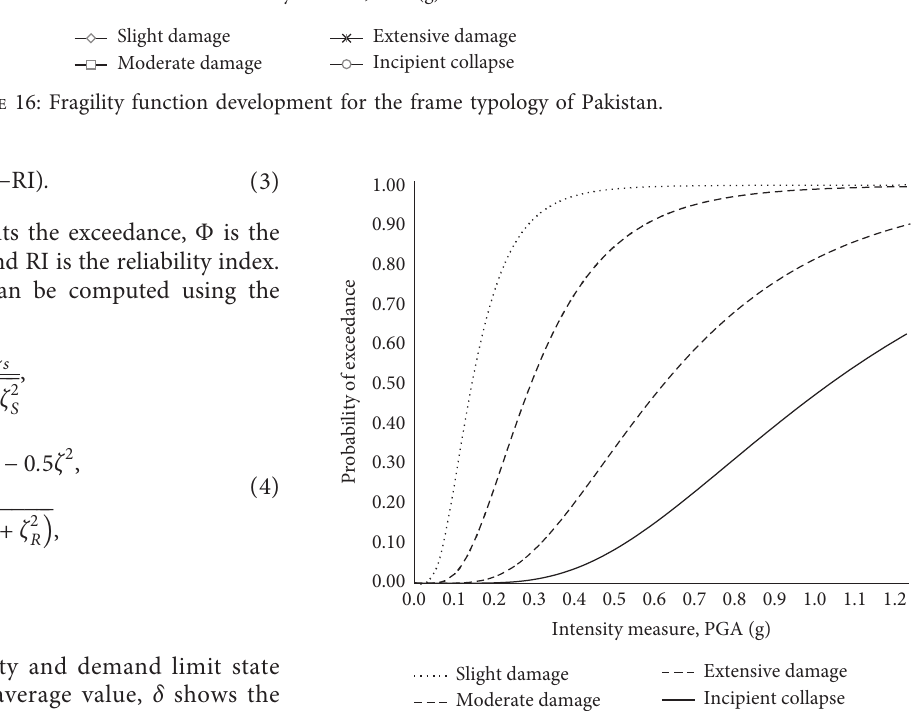
Figure 17: Fragility functions fitting based on Porter [36]. Median and standard deviation: 0.14 and 0.53 for slight damage, 0.29 and 0.53 for moderate damage, 0.62 and 0.53 for extensive damage, and 1.03 and 0.53 for incipient